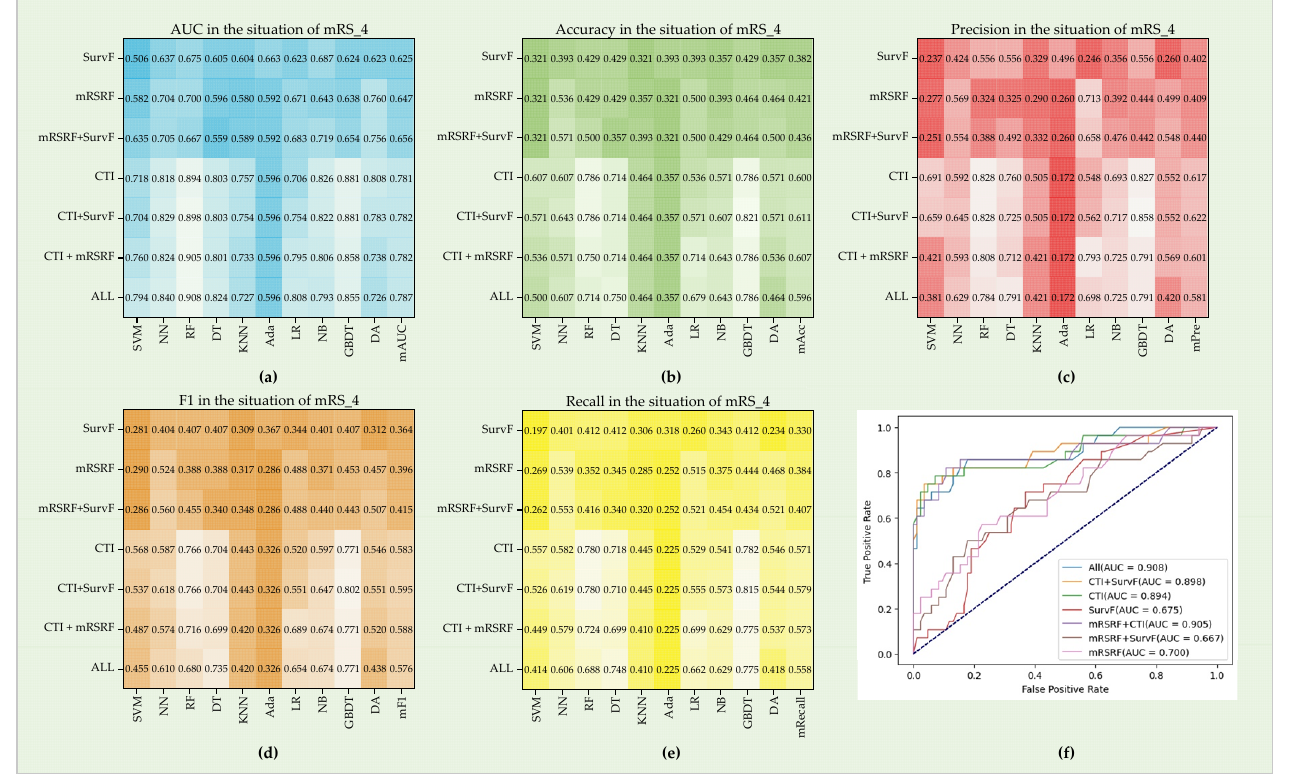
Figure 8. Performance of seven feature groups in the situation of mRS_4. ( a – e ) Auc, Pre, Acc, F1, and Recall on the ten models. ( f ) ROC curves of seven feature groups on the RF model. For mRS_7 (seen in Figure 9), the best Auc, Pre, Acc, F1, and Recall are 0.902, 0.821, 0.75, 0.739, and 0.739, respectively. From the mean of the five indexes, CTI + SurvF performs best with mAuc of 0.788, mPre of 0.519, mAcc of 0.529, mF1 of 0.495, and mRecall of 0.47, followed by CTI, ALL, CTI + mRSRF, SurvF, mRSRF + SurvF, and mRSRF. For a single-index Auc, the best score of mRSRF is 0.644, while mRSRF + SurvF is 0.668. Similarly, CTI achieves a score of 0.891, while CTI + SurvF achieves a better score of 0.902. CTI + mRSRF achieves an Auc score of 0.843, and All achieves 0.889. The seven groups show similar performance patterns in the other four indexes such that the additional SurvF will improve the outcome prediction. In this experiment group, CTI performs better than CTI + mRSRF in all the ten models. Moreover, for the ten models, RF, LR, NN, Ada, and GBDT achieve better performance than the others in all three classification situations. Overall, RF performs relatively stable, achieving good scores in all three situations. Although the survival features SurvF can improve the prediction of stroke outcomes in the three situations (mRS_2, mRS_4, and mRS_7) to varying degrees, due to the limitation of the small sample size, it is necessary to verify the methods further.